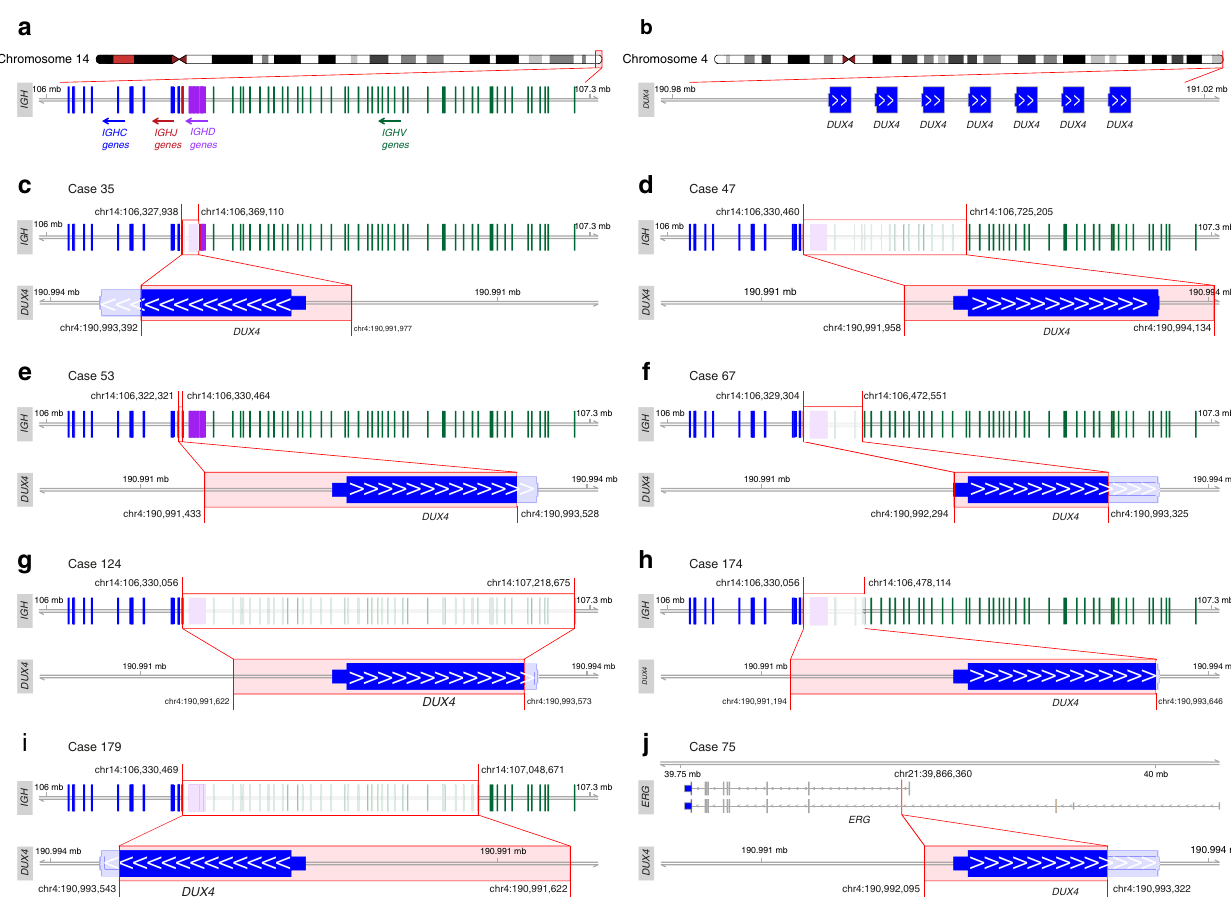
Figure 3 | DUX4 rearrangements in eight BCP ALL cases in the discovery cohort. ( a ) Arrangement of immunoglobulin genes in the IGH locus. ( b ) Structure of the subtelomeric D4Z4 repeat region on 4q in the hg19 reference genome. This reference representation has seven repeats, each containing a DUX4 gene. Healthy individuals have 11–100 repeats. ( c–i ) Structure of the IGH-DUX4 rearrangements in ( c ) case 35, ( d ) case 47, ( e ) case 53, ( f ) case 67, ( g ) case 124, ( h ) case 174 and ( i ) case 179. ( j ) Structure of the ERG-DUX4 rearrangement in case 75. All genomic coordinates are based on the human reference genome hg19. Because it is impossible to determine which DUX4 repeat is involved in the rearrangement, the coordinates from the first DUX4 repeat are represented in the